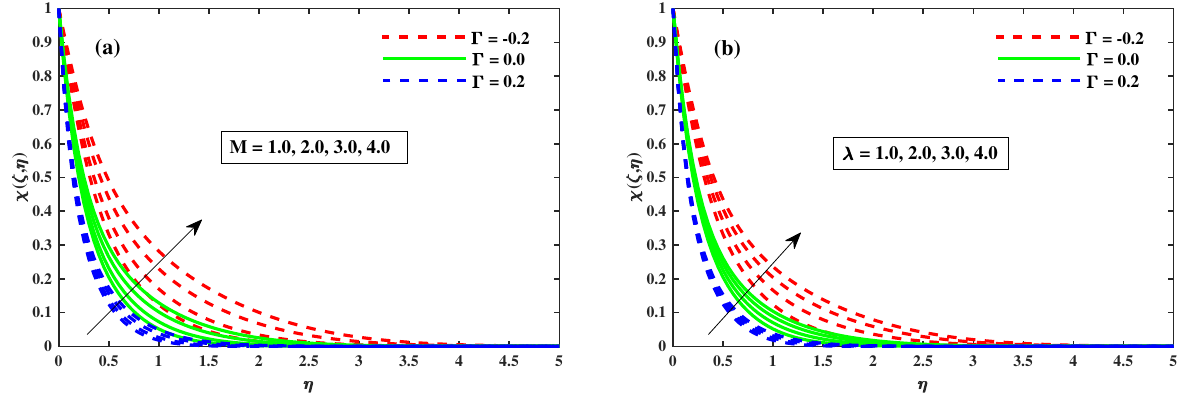
Figure 15. Influence of M in ( a ) and λ in ( b ) on χ ( ζ , η ) when ζ =